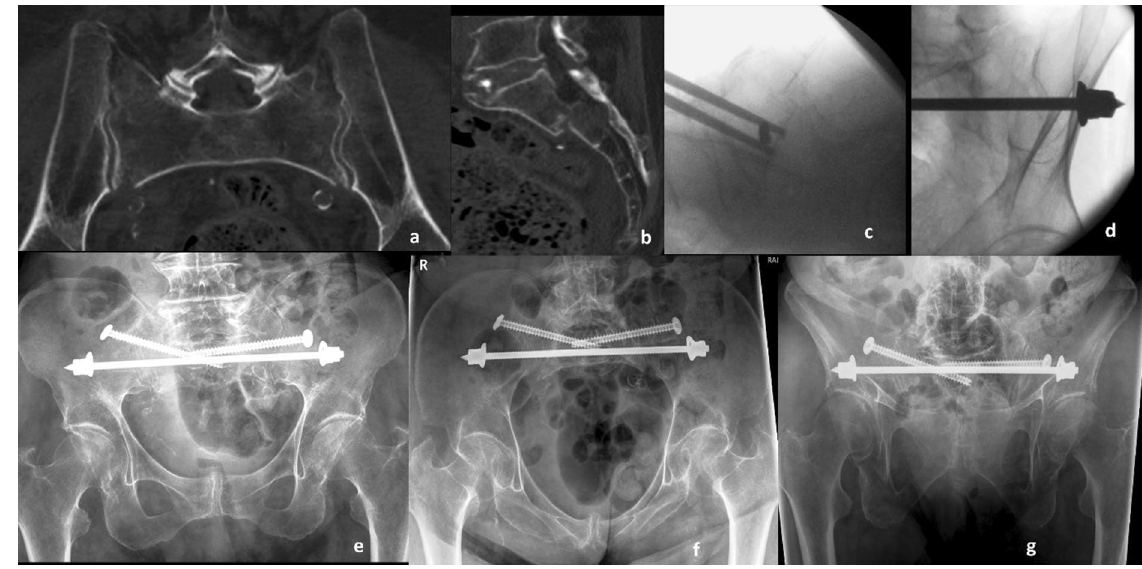
Figure 2. 92 year old female patient presenting 1 week after fall from standing height with immobilizing pain at lower lumbar spine. ( a ) Axial CT demonstrating slightly displacement of bilateral sacral fracture; ( b ) sagittal CT with displaced transversal fracture at S1/S2 level. The fracture was classified as FFP type IVb. ( c ) Lateral fluoroscopic image orientated in direction of the patient (bottom anterior, left cranial) showing overlapping of iliocortical densities and ischial notch. The drill guide is placed centrally in S1 corridor caudal to the iliocortical densities. ( d ) Oblique obturator view to assess the abutment of the washer on the iliac cortex. Postoperative control at discharge, patient is mobile with a walker (( e ) anterior–posterior, ( f ) inlet, and ( g ) outlet